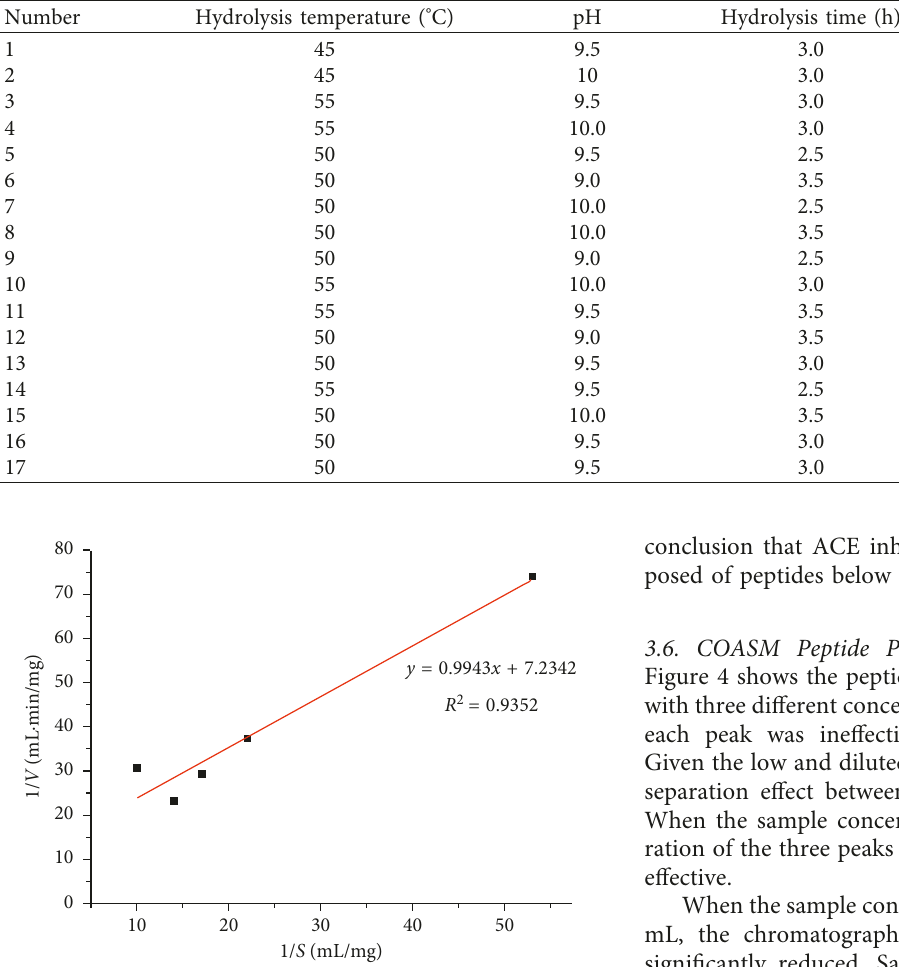
Figure 3: Equation curve of 1/V to 1/S for Lineweaver–Burk (alkaline protease). Table 2: ACE inhibition rate and IC tions in the